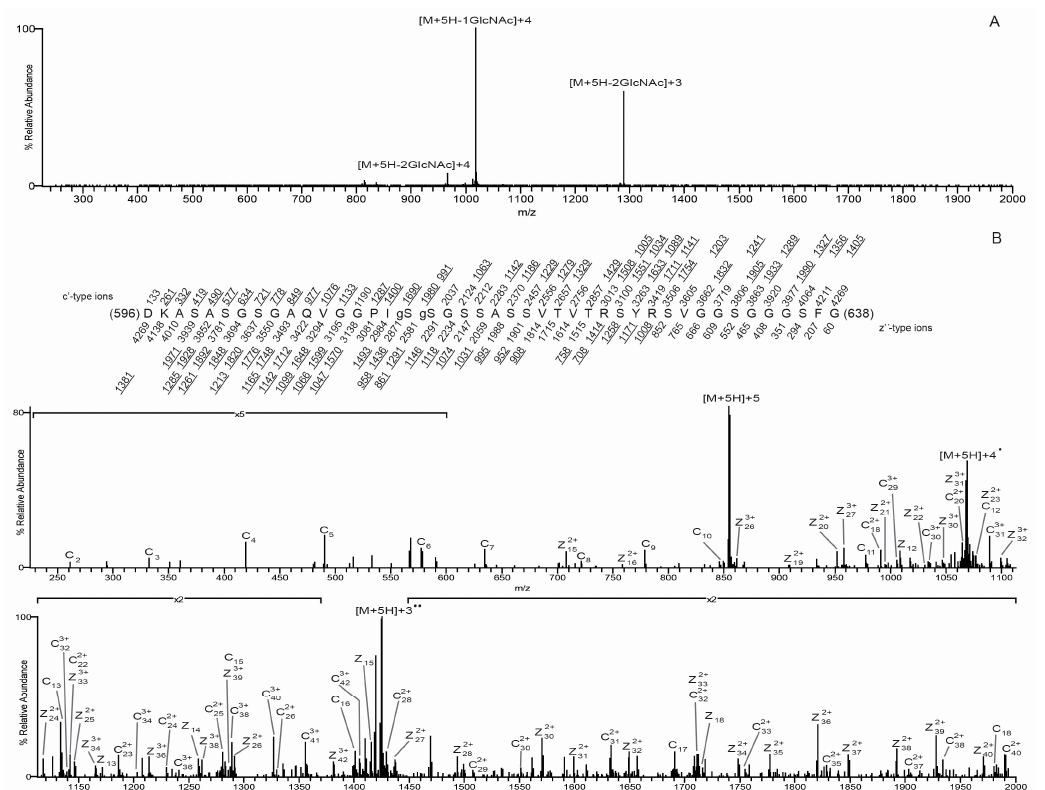
Figure 4. O -GlcNAc site mapping on the wildtype lamin A tail via liquid chromatography-MS/MS. ( A ) Collisionally activated dissociation (CAD) MS/MS spectrum recorded on the (M + 5H) 5+ ions ( m / z 855.2046) of the di-GlcNAcylated peptide DKASASGSGAQVGGPIgSgSGSSASSVTVTRSYRSVGGSGGGFG. The CAD spectrum contains the charge-reduced ions minus the loss of 1GlcNAc, 203 Da, at m / z 1018 for the +4 species, and the charge-reduced ion minus the loss of 2GlcNAc residues, 406 Da, at m / z 1289 for the +3 species and 967 for the +4 species; ( B ) an electron transfer dissociation (ETD) MS/MS spectrum recorded on the [M + 5H] 5+ ions ( m / z 855.2046) of the di-GlcNAcylated peptide DKASASGSGAQVGGPIgSgSGSSASSVTVTRSYRSVGGSGGGFG. Predicted product ions of types c’-